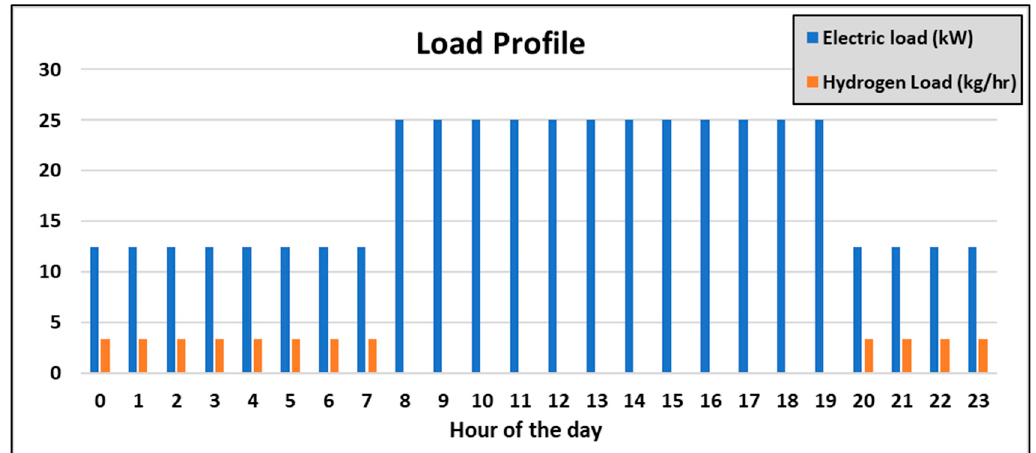
Figure 5. Hydrogen and electrical load.